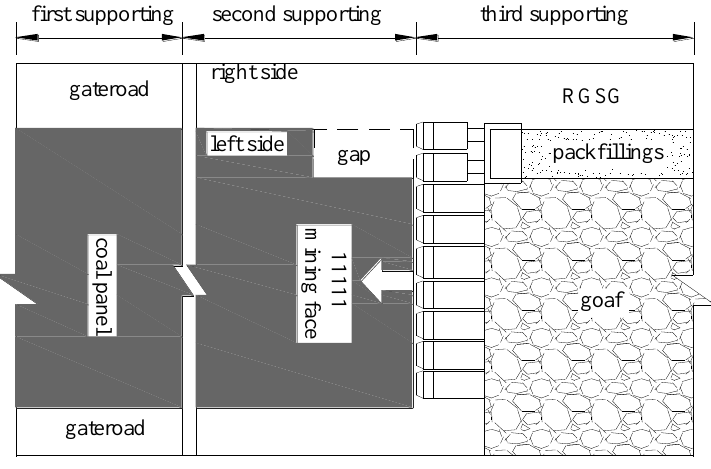
Figure 3. Distribution of the staged retained goaf-side gateroad (RGSG) supporting.